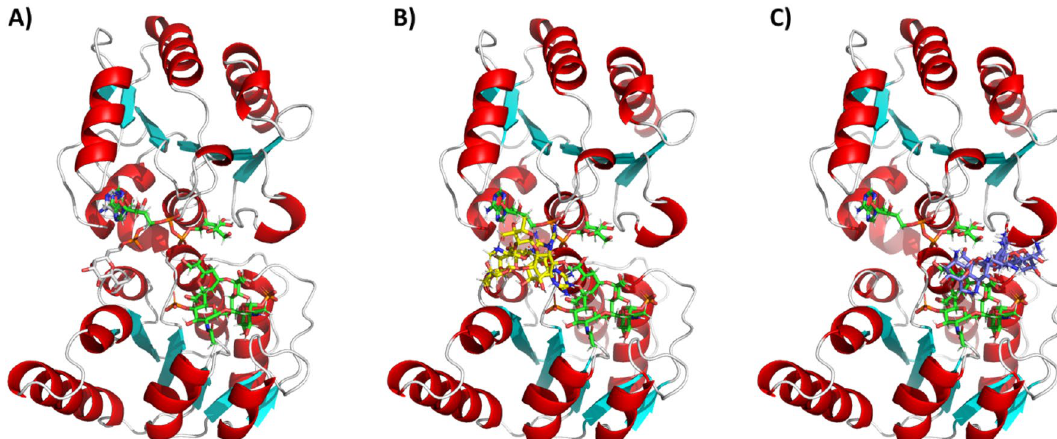
Figure 6. ( A ) Model of HepI•ADPHep •FDLA complex with the native substrates (green) and the original pseudo phosphonate derivative (white) and ( B ) the top two binding poses for Streptomycin (yellow) and ( C ) Tobramycin